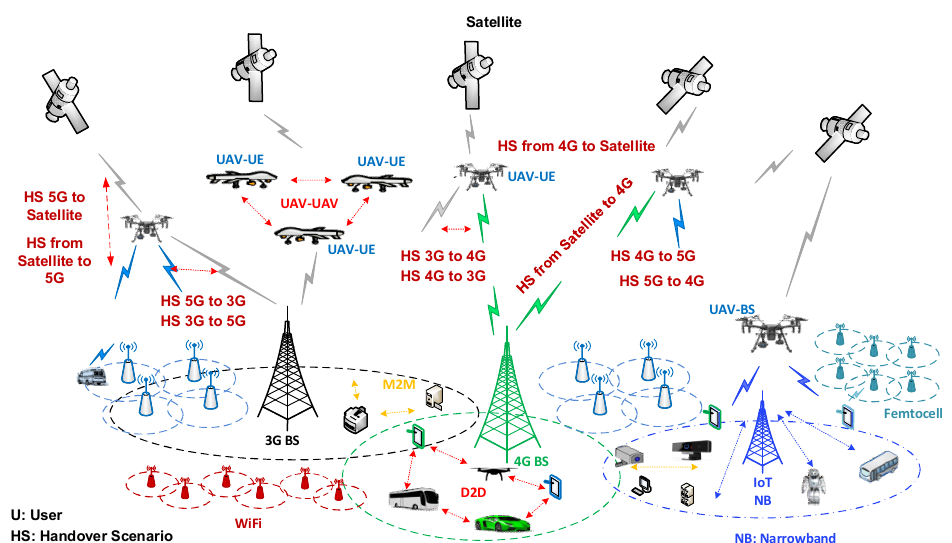
Figure 4. Handover scenarios with connected drones in future mobile networks.